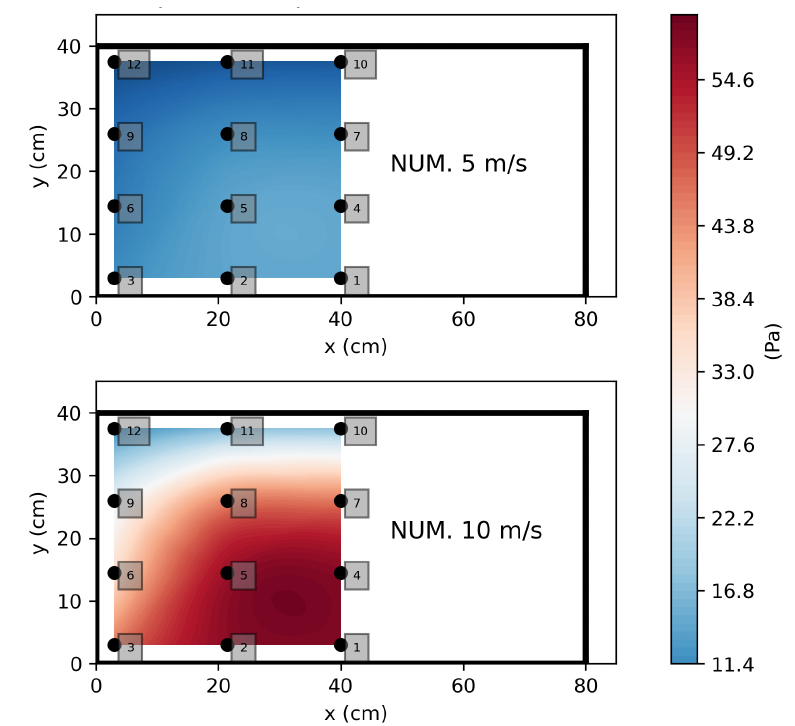
Figure 15. Numerical pressure distribution on the front side of the panel for the 5 m/s and 10 m/s